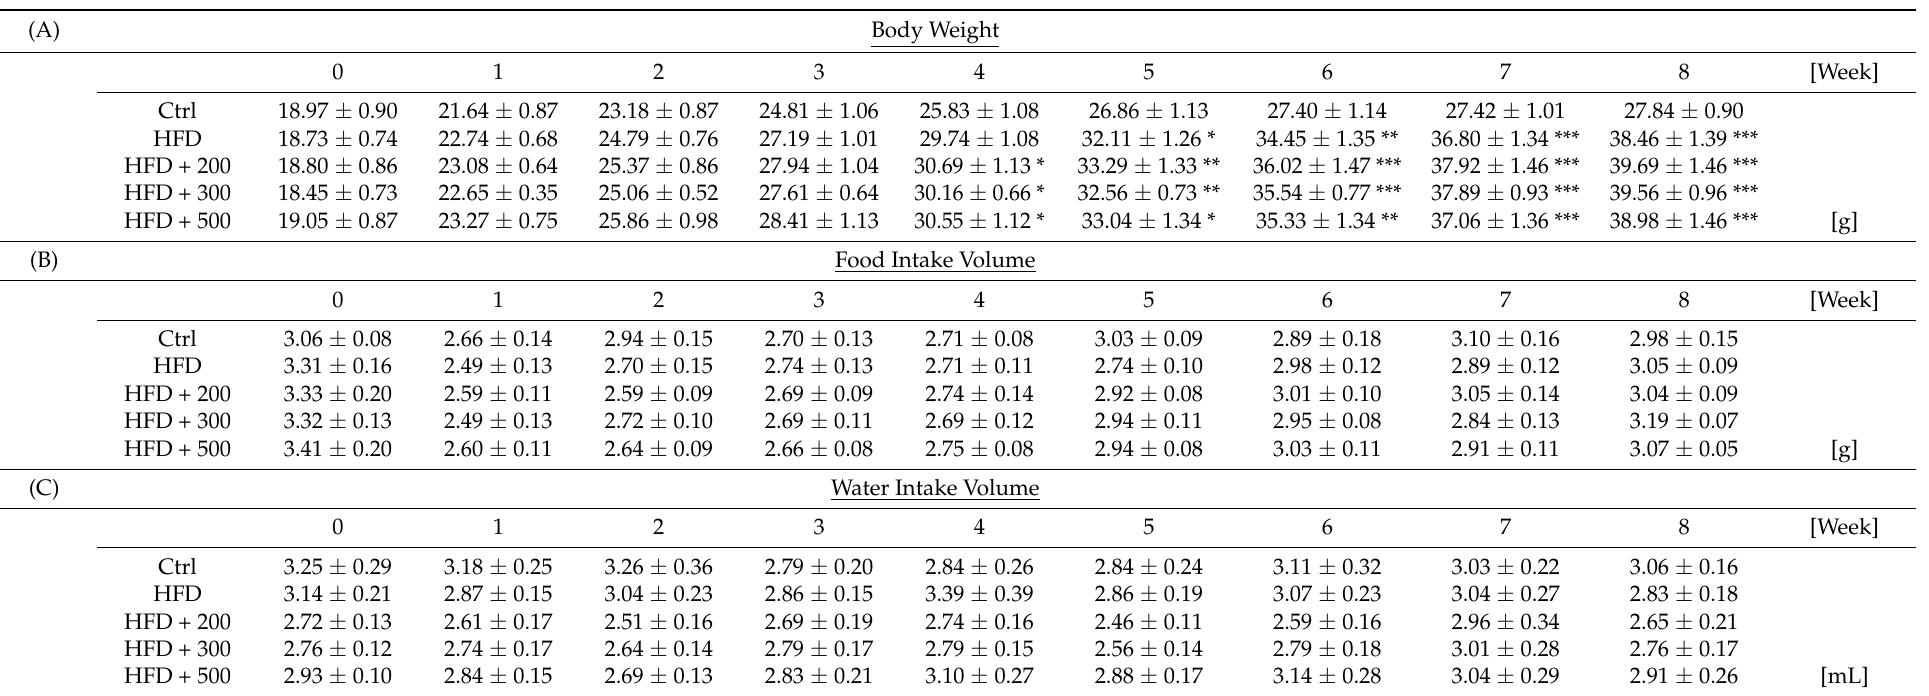
Table 1. The effects of different hardness of DSW-extract-added water in